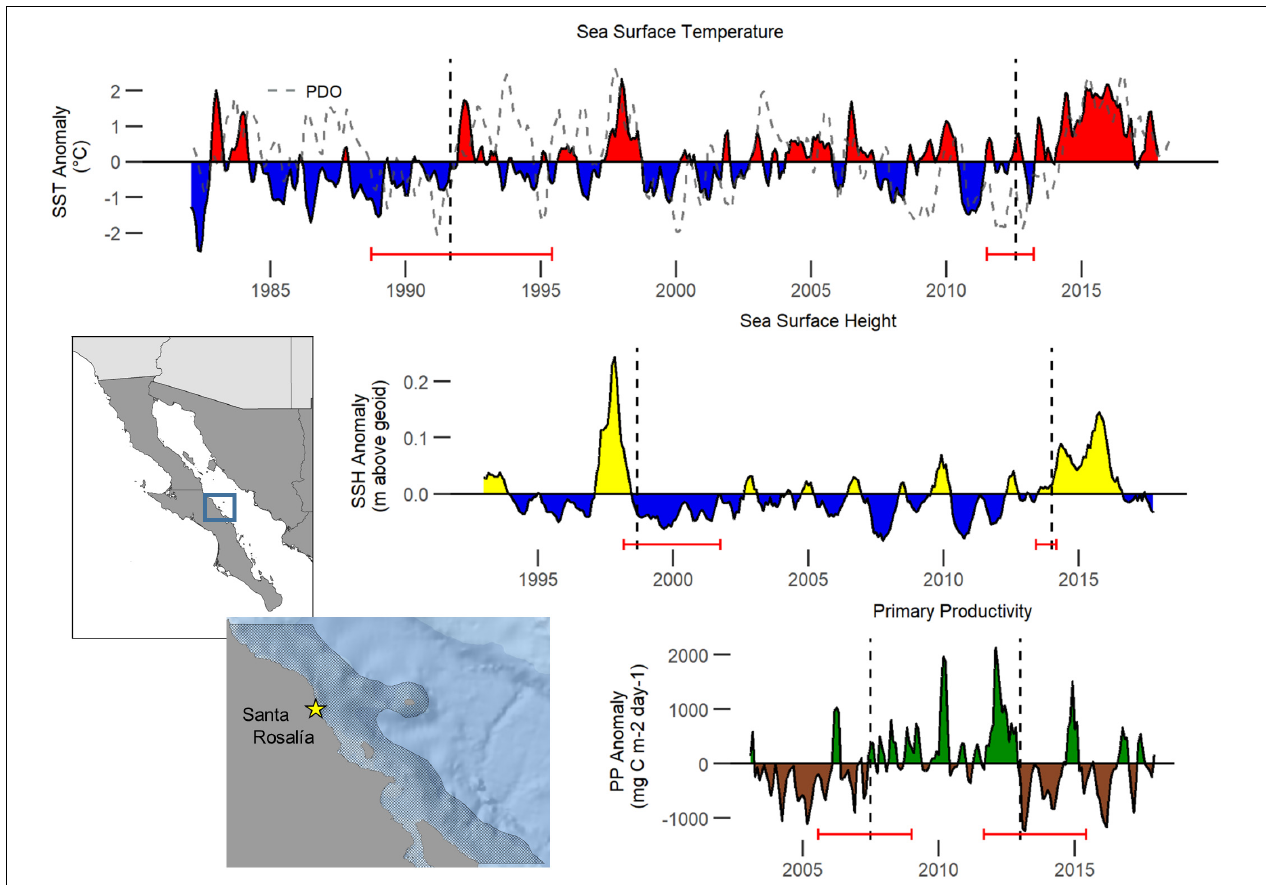
FIGURE 1 | Remotely sensed oceanographic anomalies observed offshore Santa Rosalía and detected breakpoints (+/– confidence intervals, α = 0.05). Values above zero in each panel represent positive anomalies (i.e., above the long-term average) while values below represent negative anomalies (i.e., below the long-term average). Vertical, dashed lines represent estimated structural breaks within each environmental time series. North-south fishing ranges (Frawley, unpublished data) and the 1000 m depth contour were used to determine the bounds of the sampling polygon.